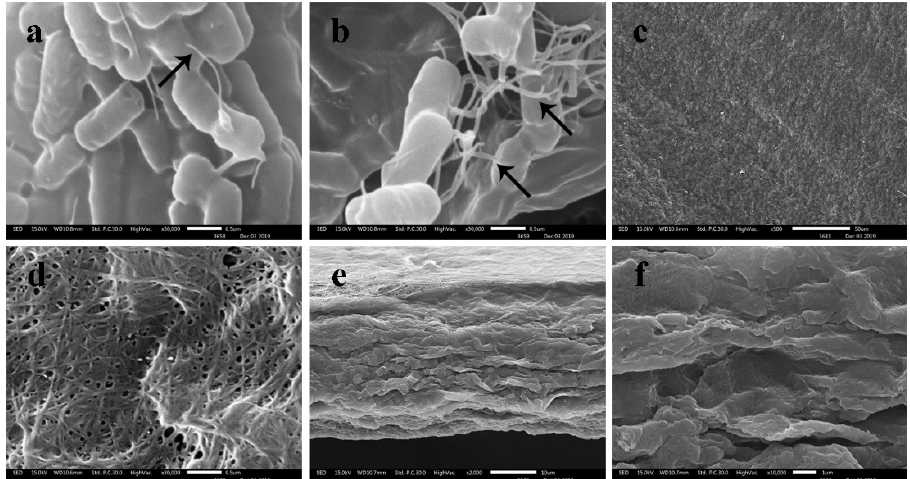
Figure 7. The SEM micrographs of K. maltaceti P285; ( a , b ) the morphological characteristic shows rod-shaped bacterium at magnification 30,000 × and the arrows indicate bacterial cellulose formation. (c,d) bacterial cellulose surface at magnification 500 × and 30,000 ×, respectively; ( e , f ) bacterial cellulose margin at magnification 2000 × and 10,000 ×, respectively. The bacterial cellulose pellicle received from K. maltaceti P285 cultivated in HS medium at 30 °C for 21 days ( c – f ).